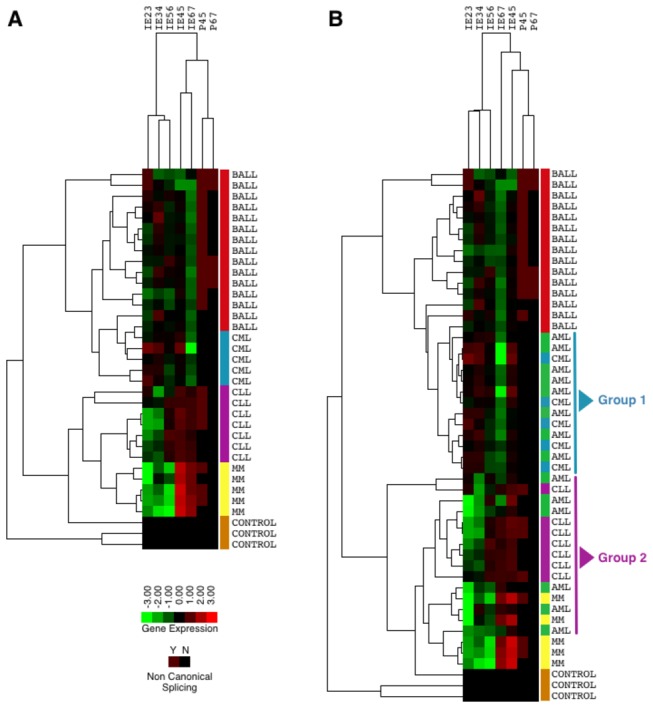
Hierarchical cluster analysis of exon differentially expressed in B-ALL, CLL, CML, AML and MM cases.Mean fluorescence intensity (MFI) values obtained for each PCR were imported and normalized according to mean MFI value observed for that PCR in control cases. Rows represent the B-ALL, CLL, CML, MM cases, while columns correspond to the normalized log2 ratios of the MFI values obtained for each inter-exon PCR analyzed. The relative level of expression of each PCR is represented in a color code: red represents expression greater than the mean, green represents expression lower than the mean, and the color intensity represents the magnitude of the deviation from the mean; the scale extends from ratios of -3 to +3 (log2 units). P4-5 and p6-7 columns represent the presence (Y) or absence (N) of non canonical splincing. (A) Cluster without the heterogeneous group of AML, (B) Cluster of all pathologies.